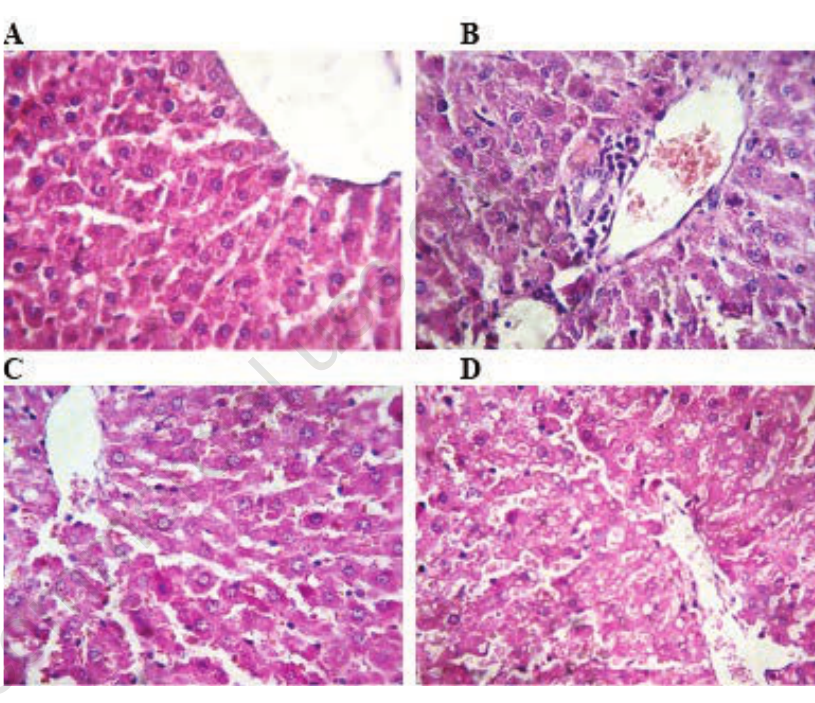
Figure 2. Photomicrograph of rat liver stained with hematoxylin and eosin: A) the histo- architecture of the liver is intact in control rats. B) Rats treated with TMX at 26